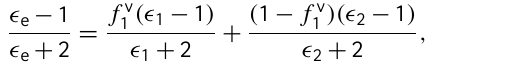
at sub-millimetre frequencies and atmospheric temperatures. agree with M06 within 1.3 %, according to the left panel of Fig. 1. Based on estimates on propagation of n (cid:48)